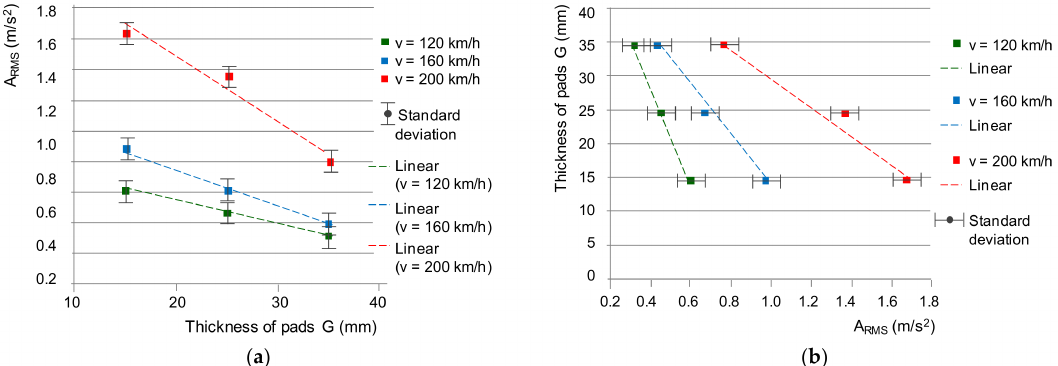
Figure 15. Characteristics of changes: ( a ) A RMS = f (G), ( b ) G = f (A RMS ) for three braking speeds in the 1950–2000 Hz frequency band.